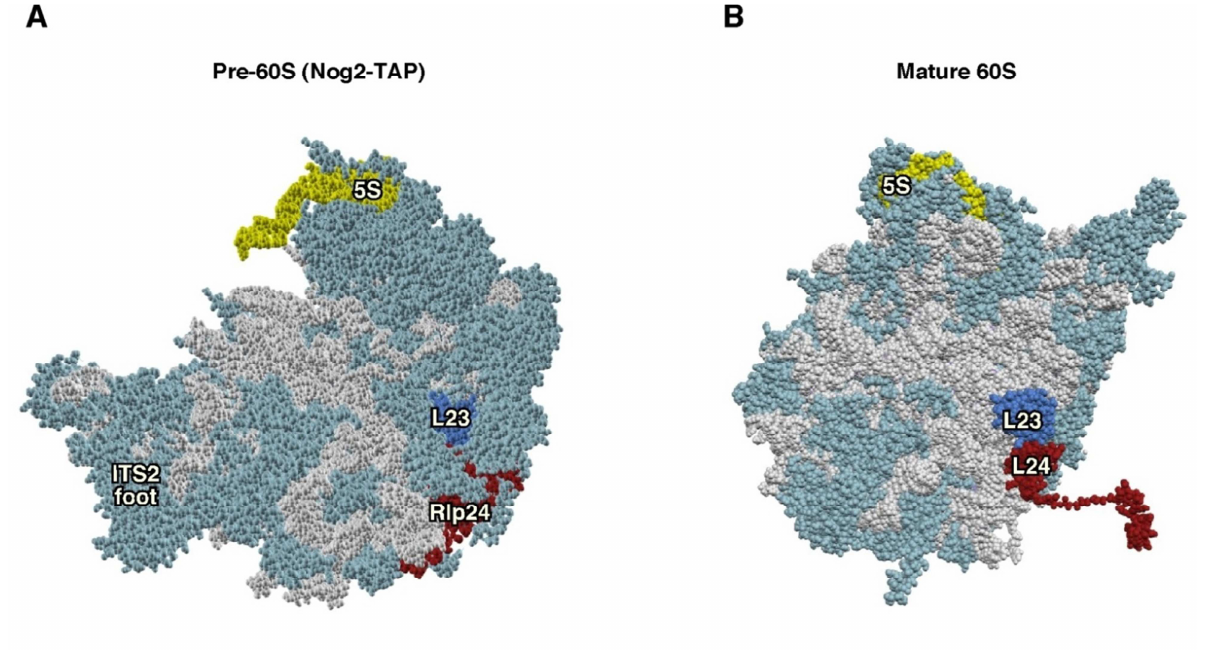
Figure 2: Rlp24 functions as a placeholder factor for the L24 r-protein. (A) Position of Rlp24 (red) in the early pre-60S r-particles purified with Nog2-TAP (PDB ID: 3JCT; [40]). (B) Position of L24 r-protein (red) in the mature 60S r-subunit (PDB ID: 3U5I, 3U5H; [44]). Particles are viewed from the subunit interface. For orientation, the positions of the 5S rRNA (yellow) and the L23 r-protein (royal blue) have been high- lighted. The ITS2 foot has also labelled in A. Note that the last ca. 50 amino acids from the C-terminal part of Rlp24 and ca. 20 amino acids from the C-terminal end of L24 could not be modelled in the respective structures. The rest of rRNAs are coloured in pale blue and the rest of r-proteins and/or factors in light cornflower